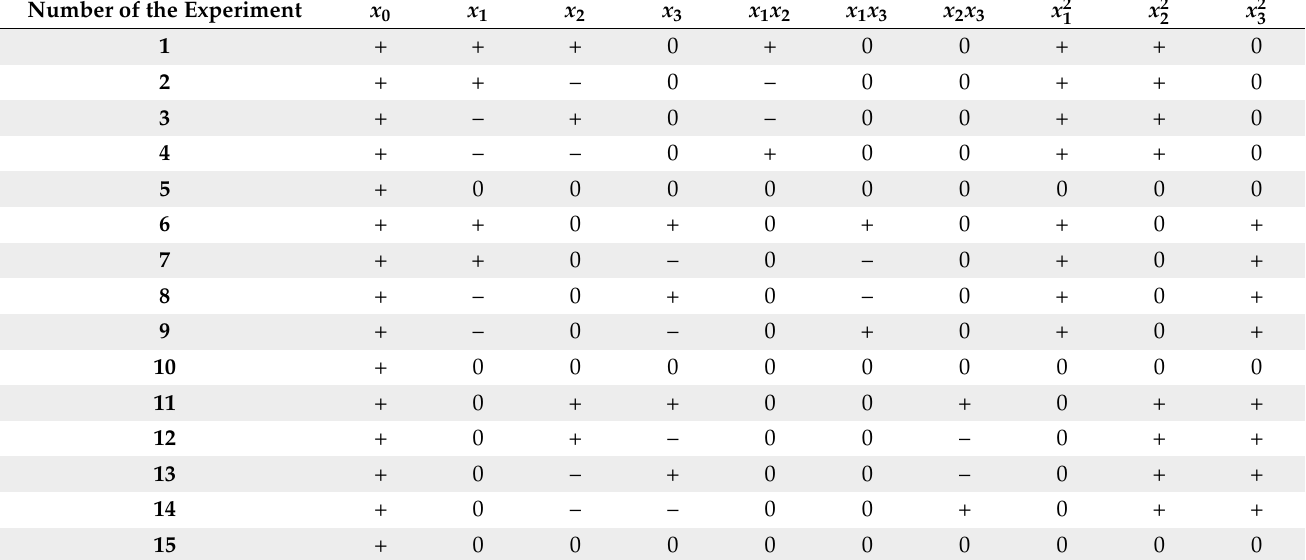
Table 1. Matrix of the non-compositional three-level second-order design for the three factors. Number of the